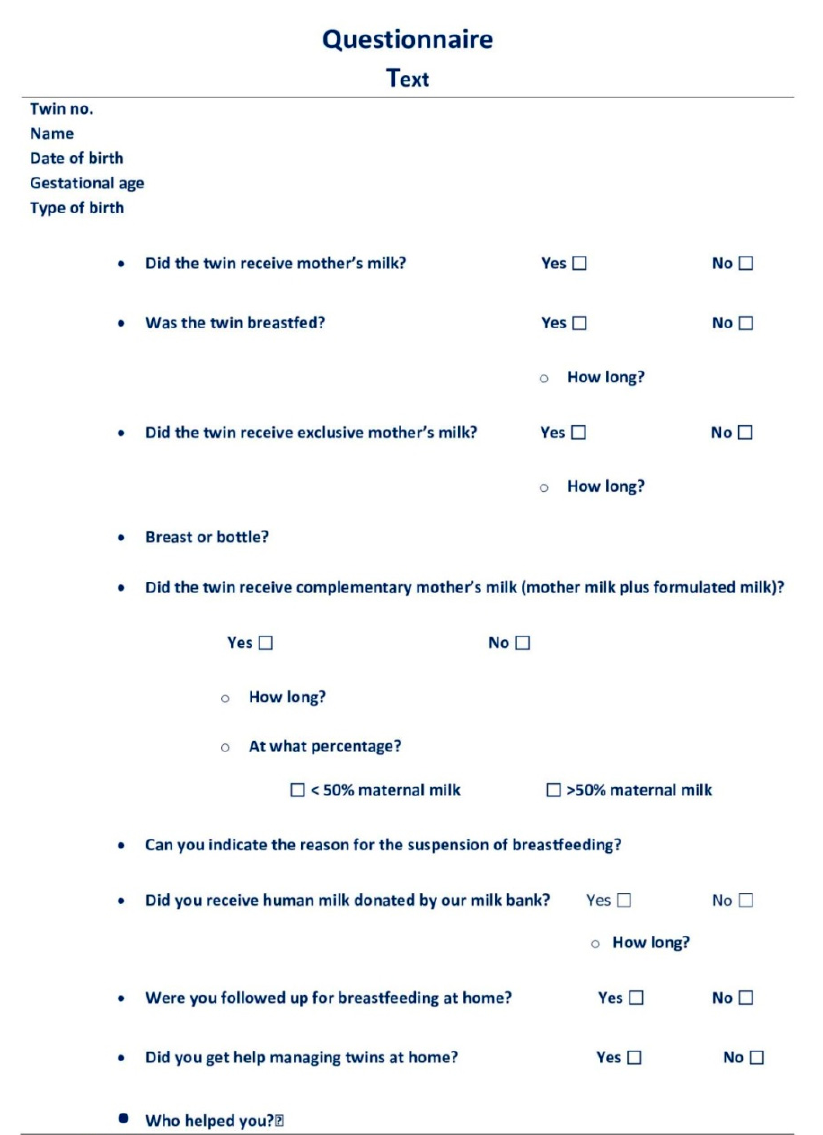
Figure 2. Questionnaire Text.